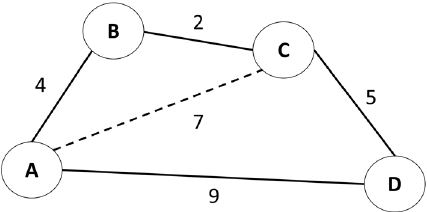
Figure 1. An example of a semi-metric network with weighted path. The dashed line represents the direct path from A to C with a weight of 7. However, there exists a shorter circuitous path from A to C via B with a sum of weight of 6. This is called an indirect